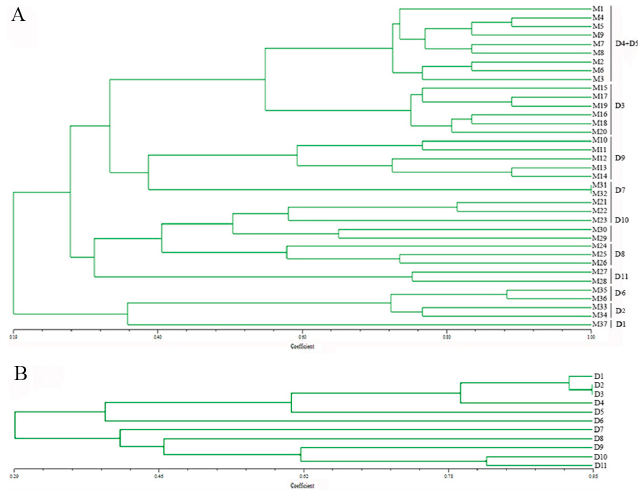
Figure 3. Unweighted pair group method with arithmetic mean (UPGMA) dendrograms of Bailinggu based on 18 novel EST-SSR markers. ( A ) UPGMA dendrogram of 37 monokaryons of Bailinggu based on 18 novel EST-SSR markers. M1–M37 represented monokaryons obtained from parent dikaryons. D1–11 represented the parent dikaryotic strains: D1-CCMJ814, D2-CCMJ1077, D3-CCMJ967, D4-CCMJ974, D5-CCMJ968, D6-CCMJ1044, D7-CCMJ980, D8-CCMJ1001, D9-CCMJ1002, D10-CCMJ973, D11-CCMJ1123. ( B ) UPGMA dendrogram of 11 parent dikaryotic strains of Bailinggu based on the same 18 novel EST-SSR markers.